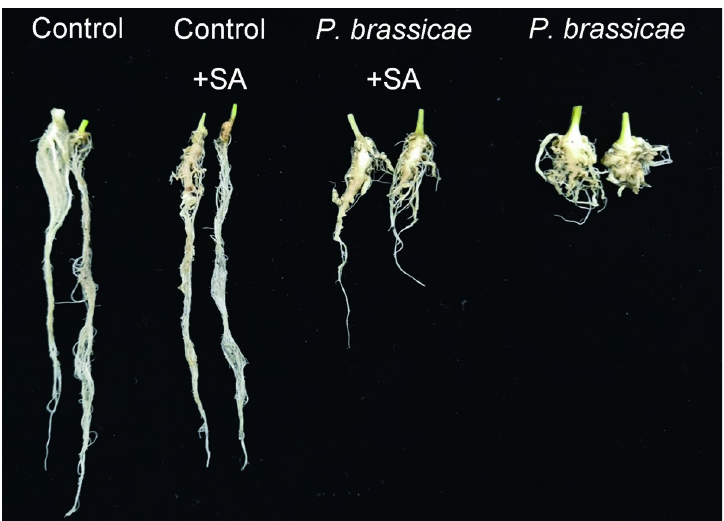
Fig 1. Forty-day old plant roots. Control and Control+SA: Uninoculated plants treated with ethanol or 0.6 mM SA at forty-day-old; respectively. P . brassicae and P . brassicae +SA: Plants sowed in mixed soil (with P . brassicae ) treated with ethanol or 0.6 mM SA, respectively.